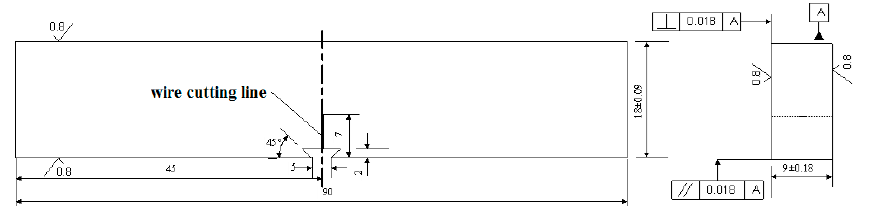
Figure 5. Fracture toughness test piece.